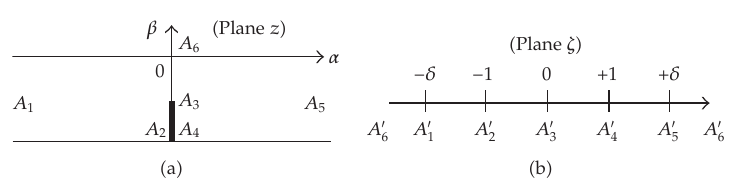
Figure 3: Transformation of the plane (cid:3) z (cid:6) on the half plane (cid:3) ζ (cid:6)